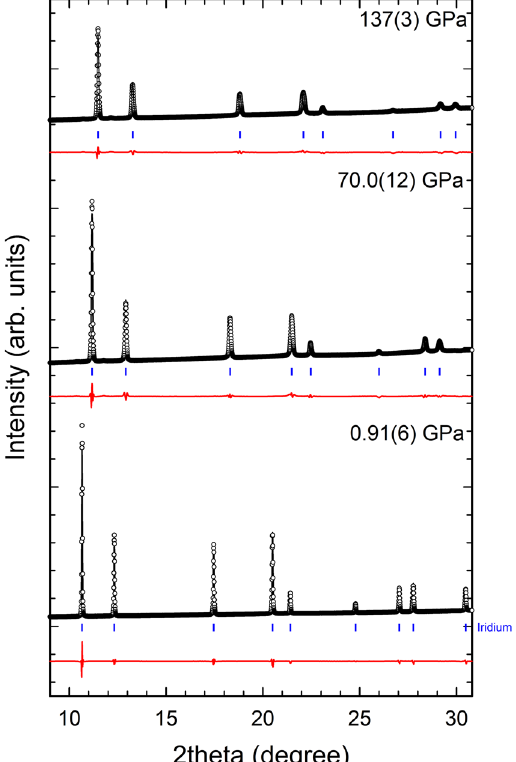
Figure 1. Rietveld refinements of diffraction patterns at 0, 70 and 137 GPa. Black empty circle line corresponds to the measured XRD pattern, black (red) solid line shows the refinement (residual) and the blue ticks are the position of Bragg peaks of